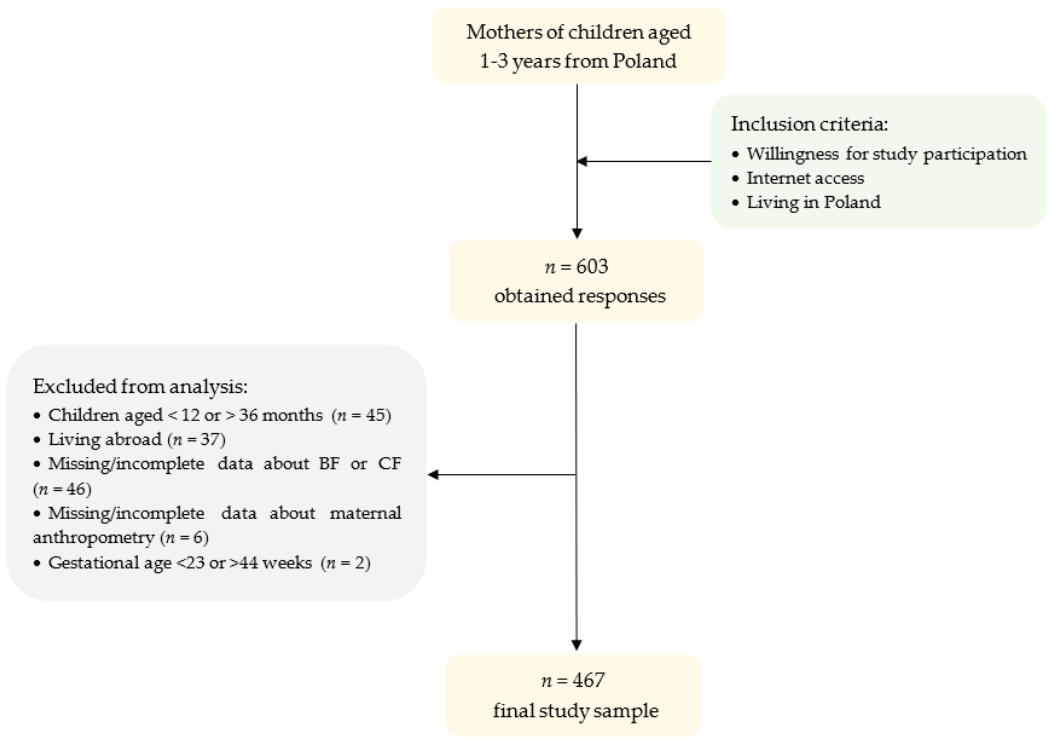
Figure 1. Flowchart presenting exclusion criteria and study population. BF — breastfeeding; CF — complementary feeding.